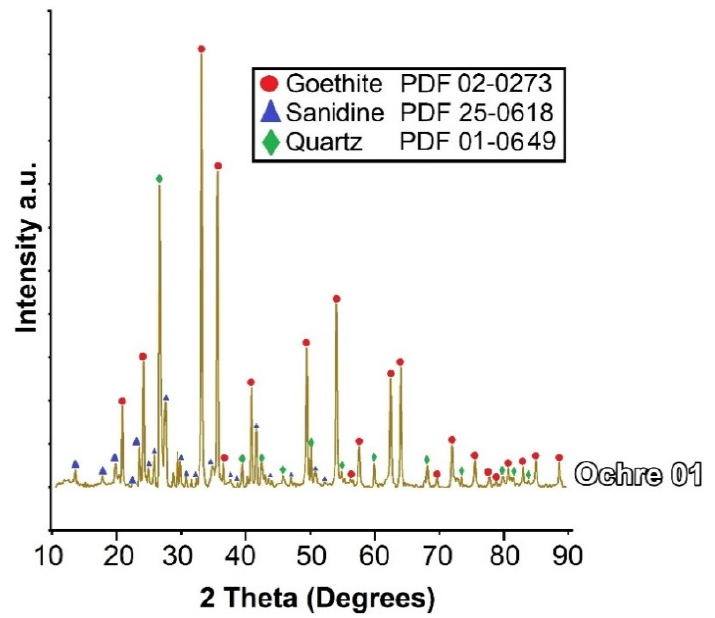
Figure 9. X-ray diffractogram of the ochre pigment.